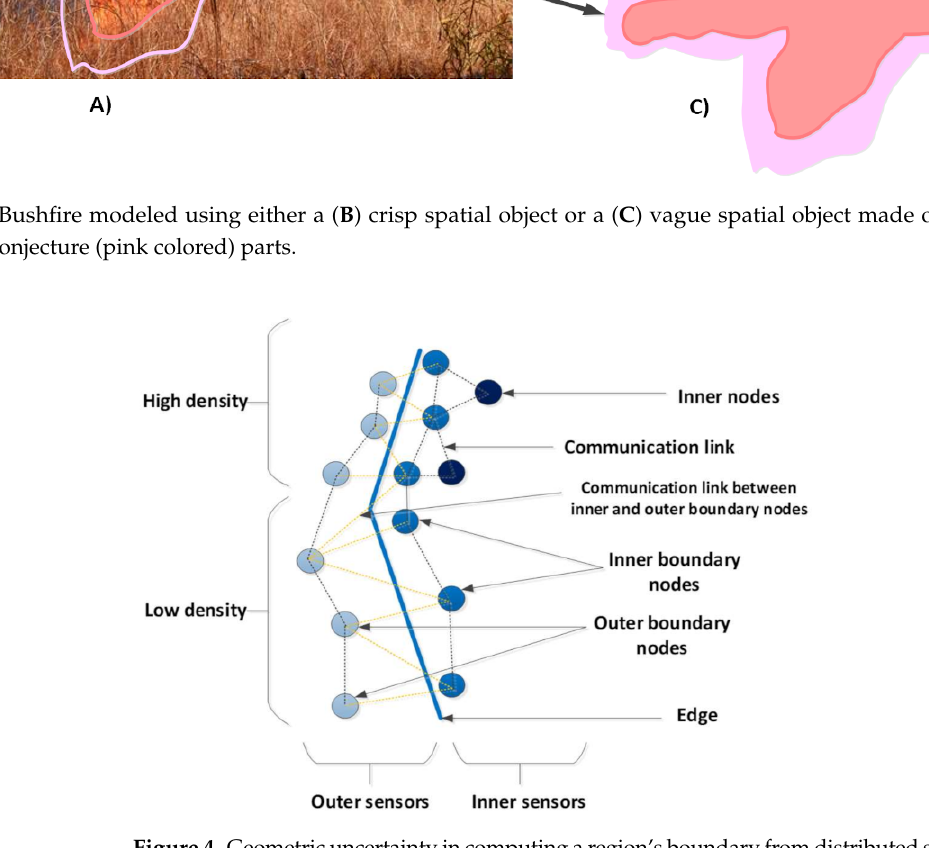
Figure 4. Geometric uncertainty in computing a region’s boundary from distributed sensor